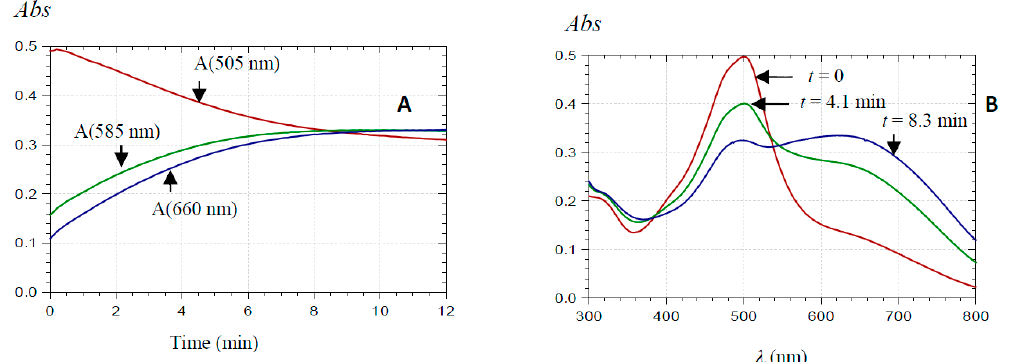
Figure 6. ( A ) Changes in visible absorbance following the addition of PA1 (48.4 µM) to a pH 5.20 acetate buffer + 12% EtOH; and ( B ) UV-visible spectra at different time points.